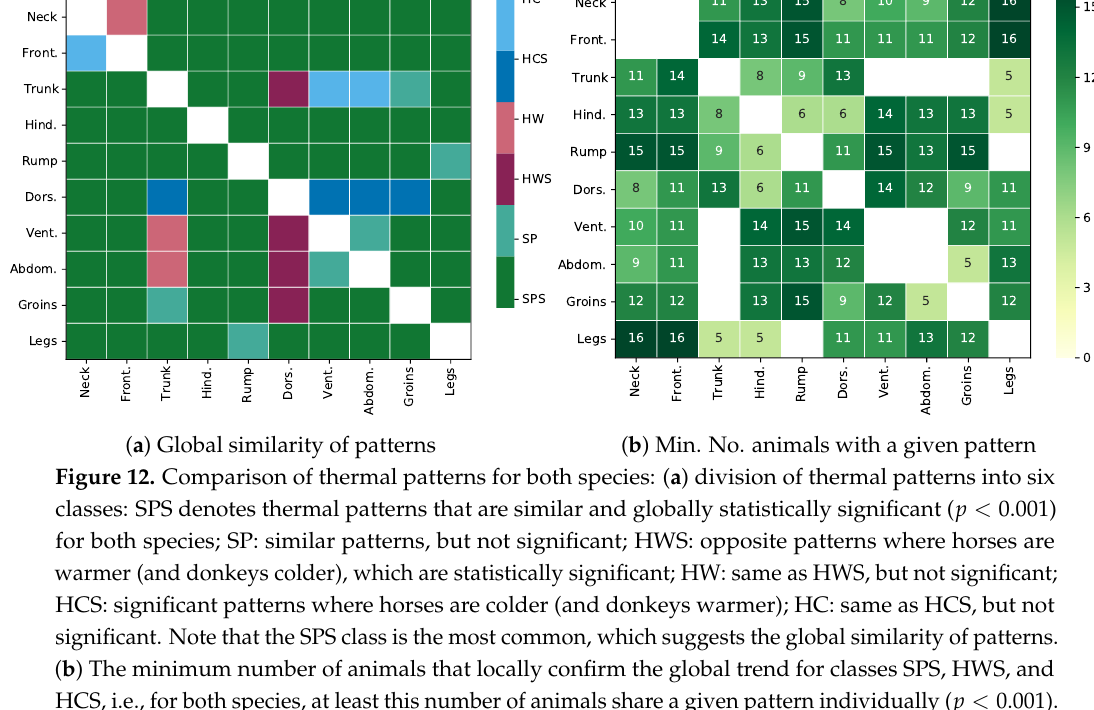
( b ) Min. No. animals with a given pattern Figure 12. Comparison of thermal patterns for both species: ( a ) division of thermal patterns into six classes: SPS denotes thermal patterns that are similar and globally statistically significant ( p < 0.001) for both species; SP: similar patterns, but not significant; HWS: opposite patterns where horses are warmer (and donkeys colder), which are statistically significant; HW: same as HWS, but not significant; HCS: significant patterns where horses are colder (and donkeys warmer); HC: same as HCS, but not significant. Note that the SPS class is the most common, which suggests the global similarity of patterns. ( b ) The minimum number of animals that locally confirm the global trend for classes SPS, HWS, and HCS, i.e., for both species, at least this number of animals share a given pattern individually ( p < 0.001). Note that the maximum value in the table is 16, which indicates a stable